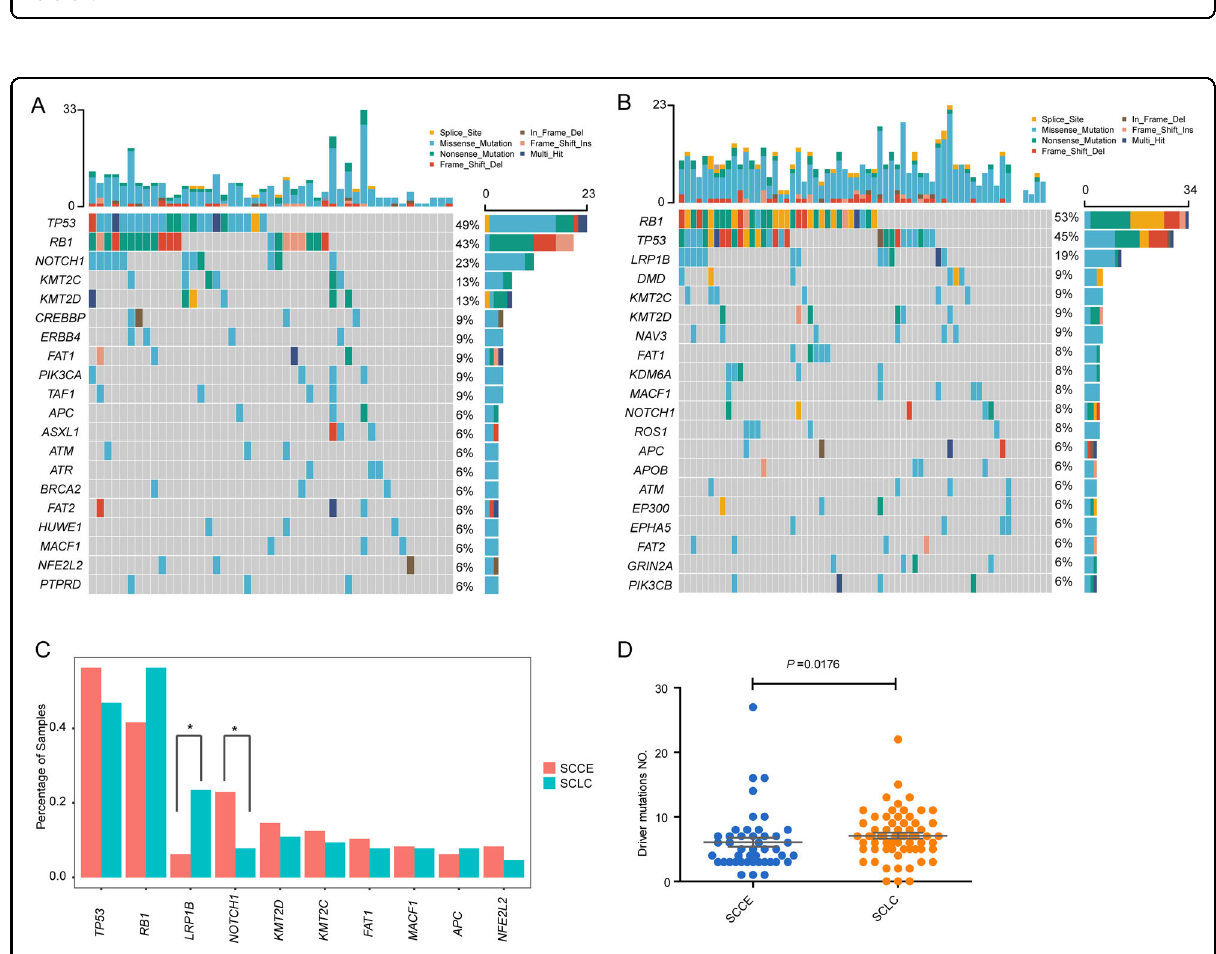
Fig. 1 Study design and pipeline. FFPE of patients with SCCE and SCLC was sequenced using WES. Somatic mutations were evaluated with Pure CN.